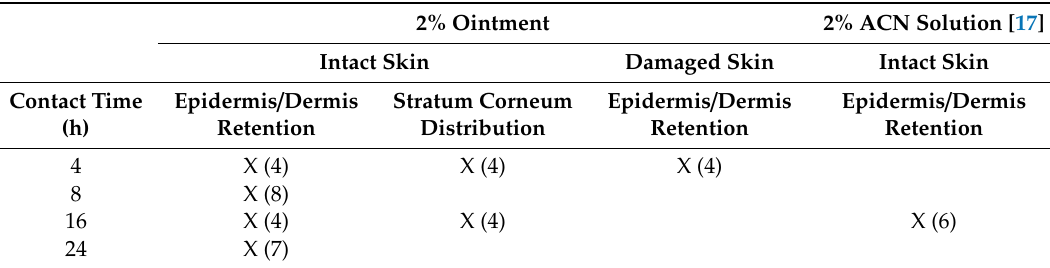
Table 2. Conditions tested in skin permeation and retention experiments (the number of replicates is indicated in